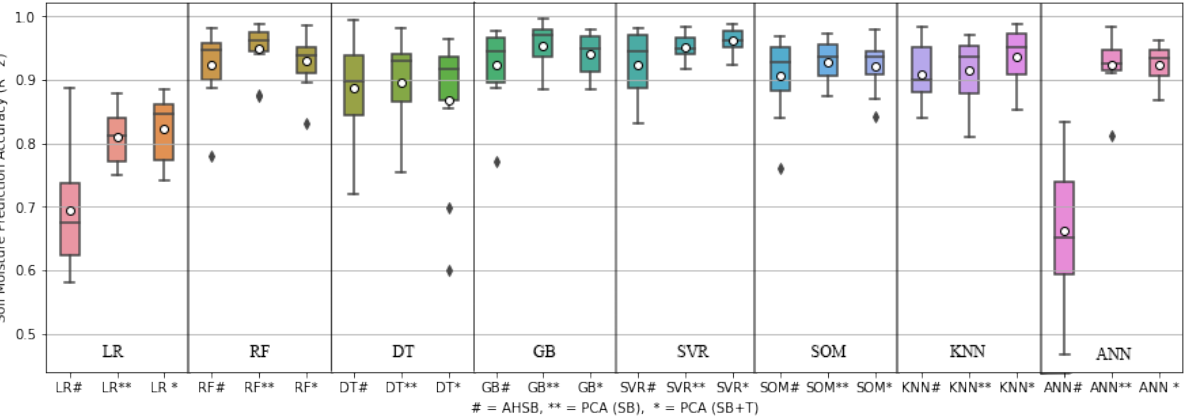
Figure 11. Box-plot of different ML approaches used to predict soil moisture, where black-diamond shows the outliers.